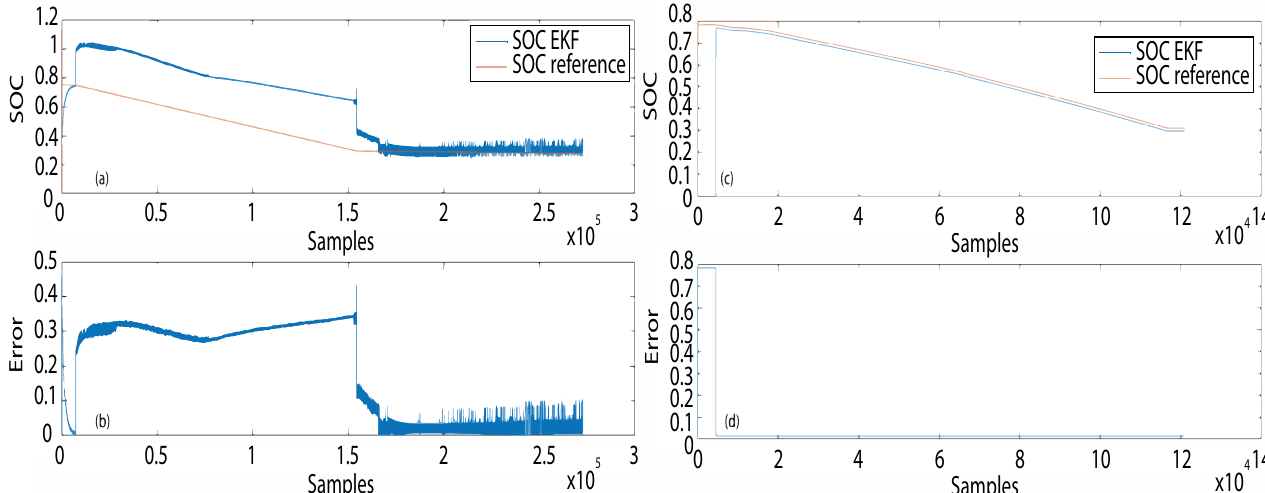
Figure 10. Results of the variable current discharge test with the DCC-EKF approach.